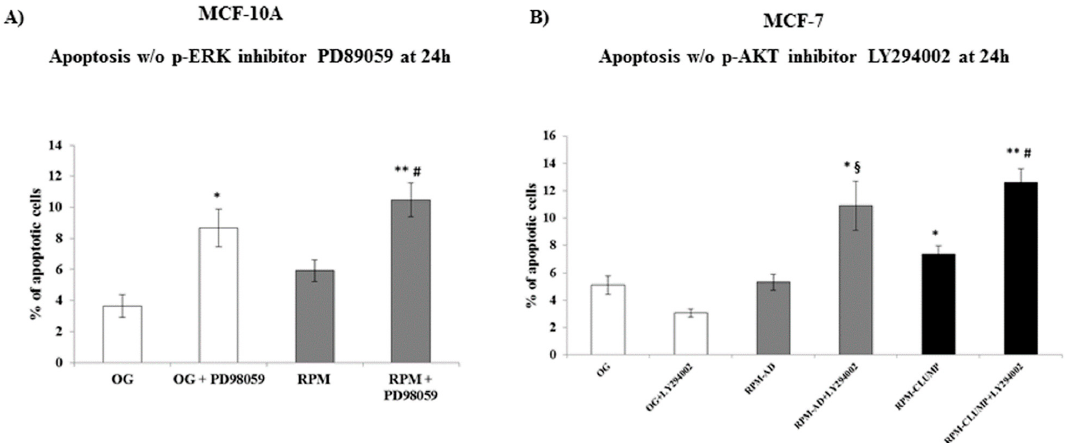
Figure 12. Apoptosis analysis in MCF-10A ( A ) and MCF-7 ( B ) cells at 24 h after exposition to weightlessness w/o the p-ERK inhibitor, PD89059, and w/o the p-AKT inhibitor, LY294002, respectively. Bar charts/graphs show the percentage of apoptotic cells (Annexin V+/7-AAD-); each column represents the mean value ± SD of three independent experiments. In MCF-10A, * p < 0.05, ** p < 0.01 vs. OG; # p < 0.05 vs. RPM by ANOVA followed Bonferroni post-test. In MCF-7 * p < 0.05, ** p < 0.01 vs. OG; § p < 0.05 vs. RPM-AD; # p < 0.05 vs. RPM-CLUMP by ANOVA followed by Bonferroni post-test.